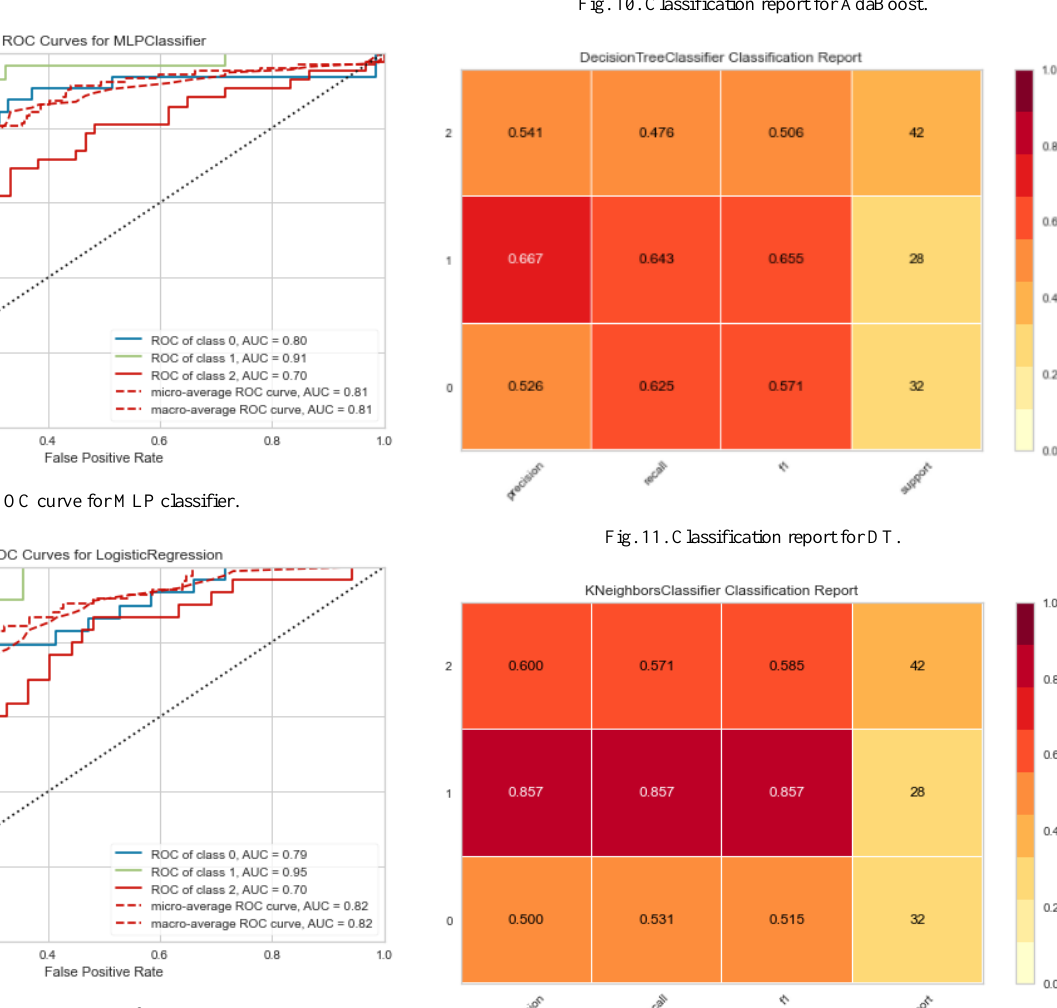
Fig. 7. ROC curve for KNN classifier.